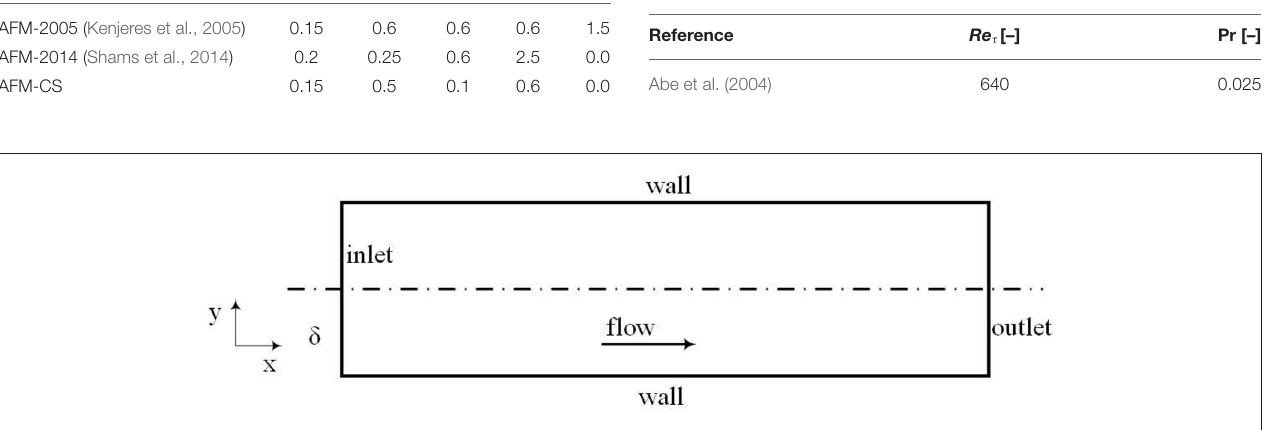
TABLE 2 | Dimensionless numbers for validating the CFD approach employed.